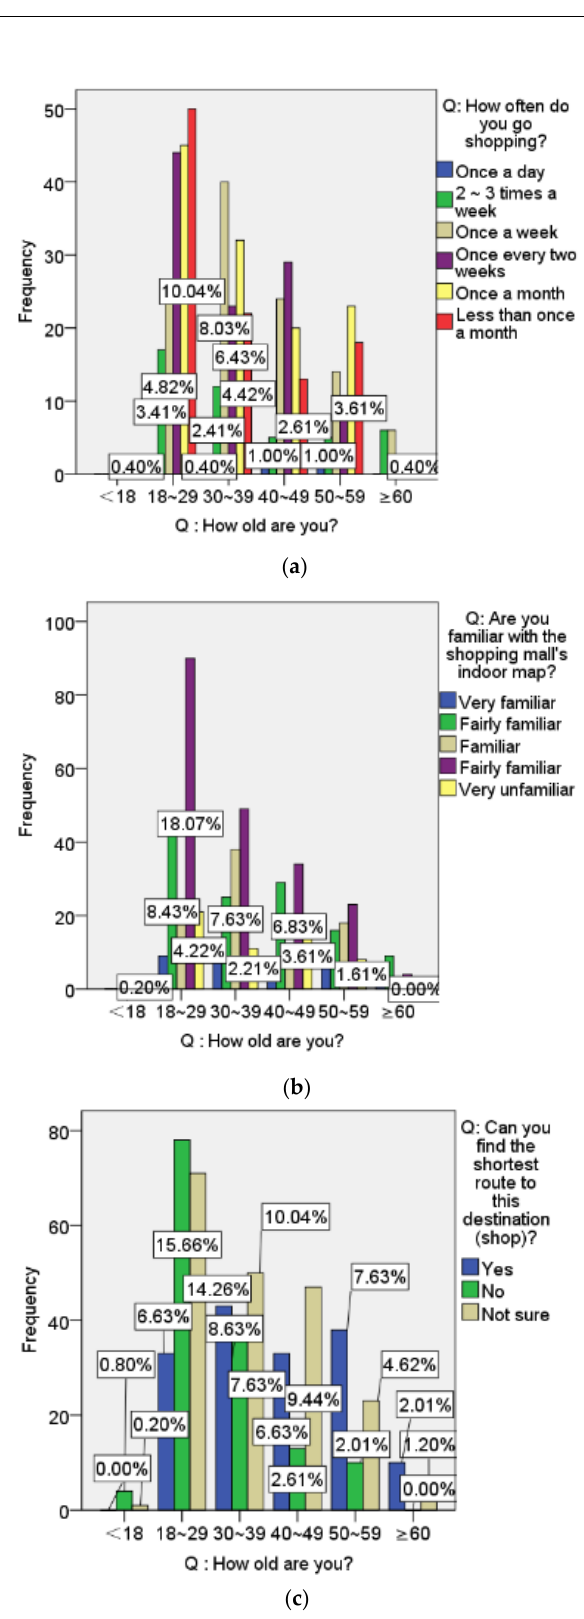
Figure 12. Frequency comparison between “Age” and personal data related to shopping behavior. ( a ) Shopping mall frequency; ( b ) Be familiar with the indoor map of shopping mall; ( c ) Whether the shortest path can be found.